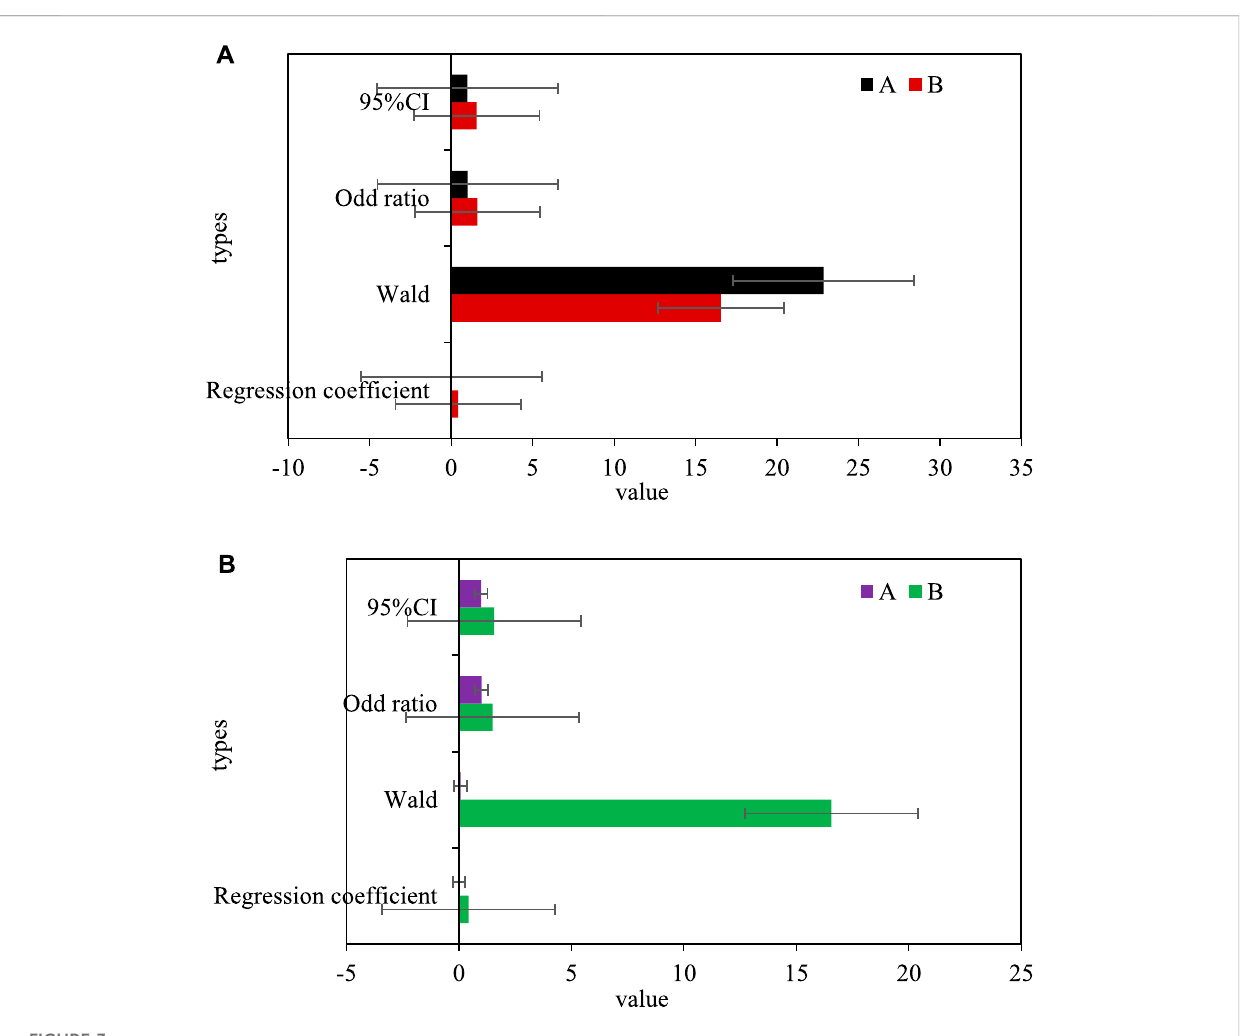
FIGURE 3 (A) Univariate logistic risk factor analysis of in fl ammatory markers and ureteral urothelial carcinoma. (B) Multivariate logistic risk factor analysis of in fl ammatory indicators and ureteral urothelial